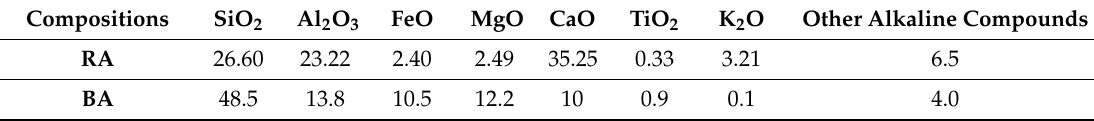
Table 5. Chemical composition of the basalt and recycled aggregate (%) (own research).